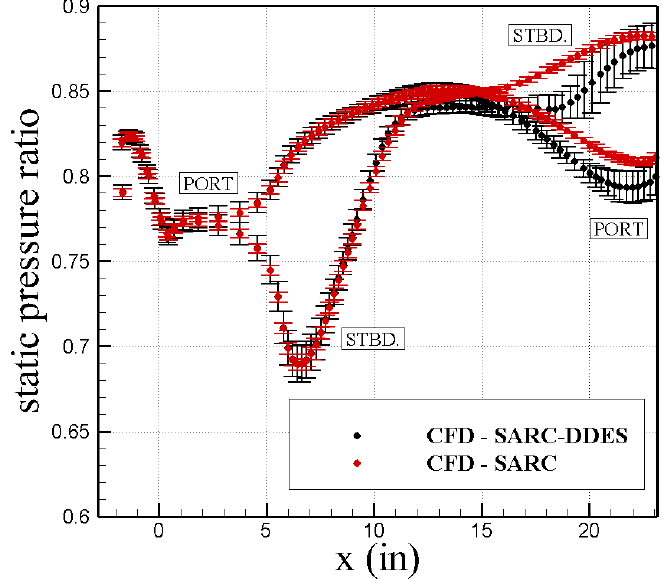
Figure 11. Unsteadiness in solutions of M2129 intake. Dot markers show time-averaged static to free-stream total pressure value of the NASA baseline grid. Bar denotes maximum difference from averaged values. Static pressure ratio ( p f / p 0 ∞ ) is the ratio of averaged engine face static pressure to free-stream total